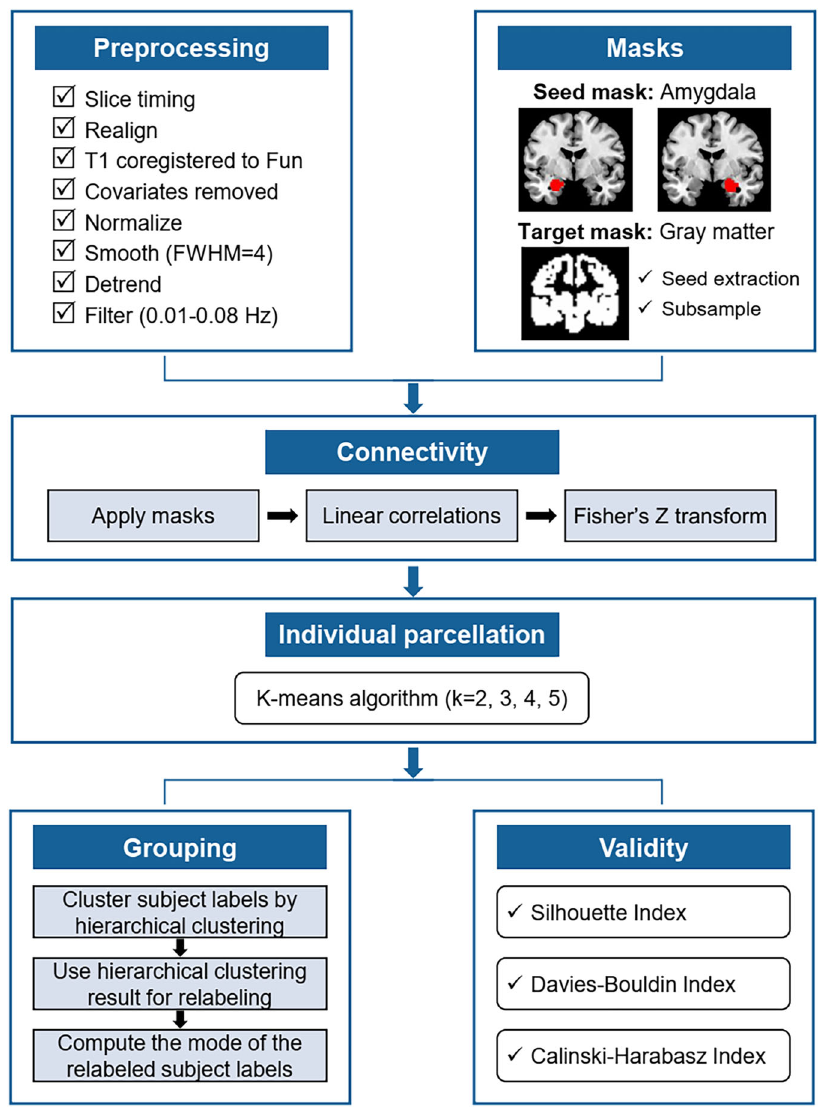
Fig. 4 Flowchart of the methods. Procedures of resting-state functional MRI data preprocessing and amygdala